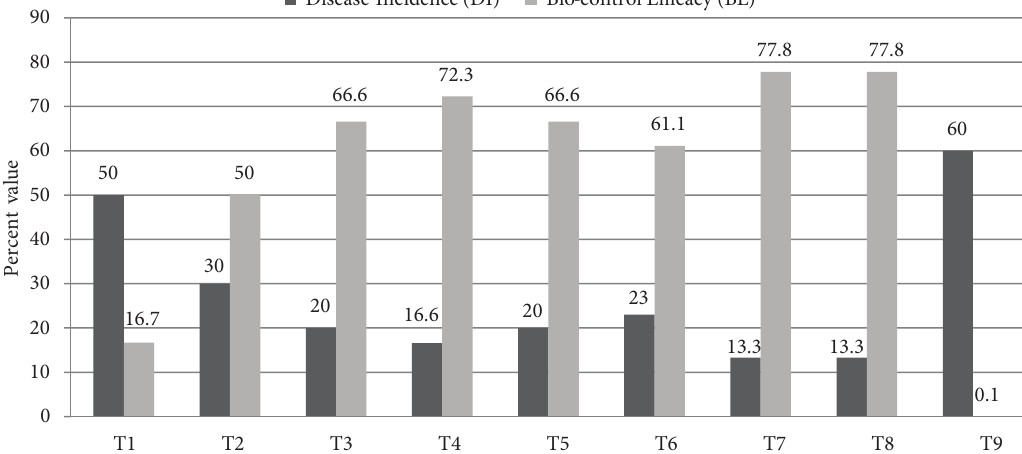
Figure 2. Field evaluation of rhizobacteria on Disease incidence (DI) and Bio-control efficacy (BE) in Cowpea